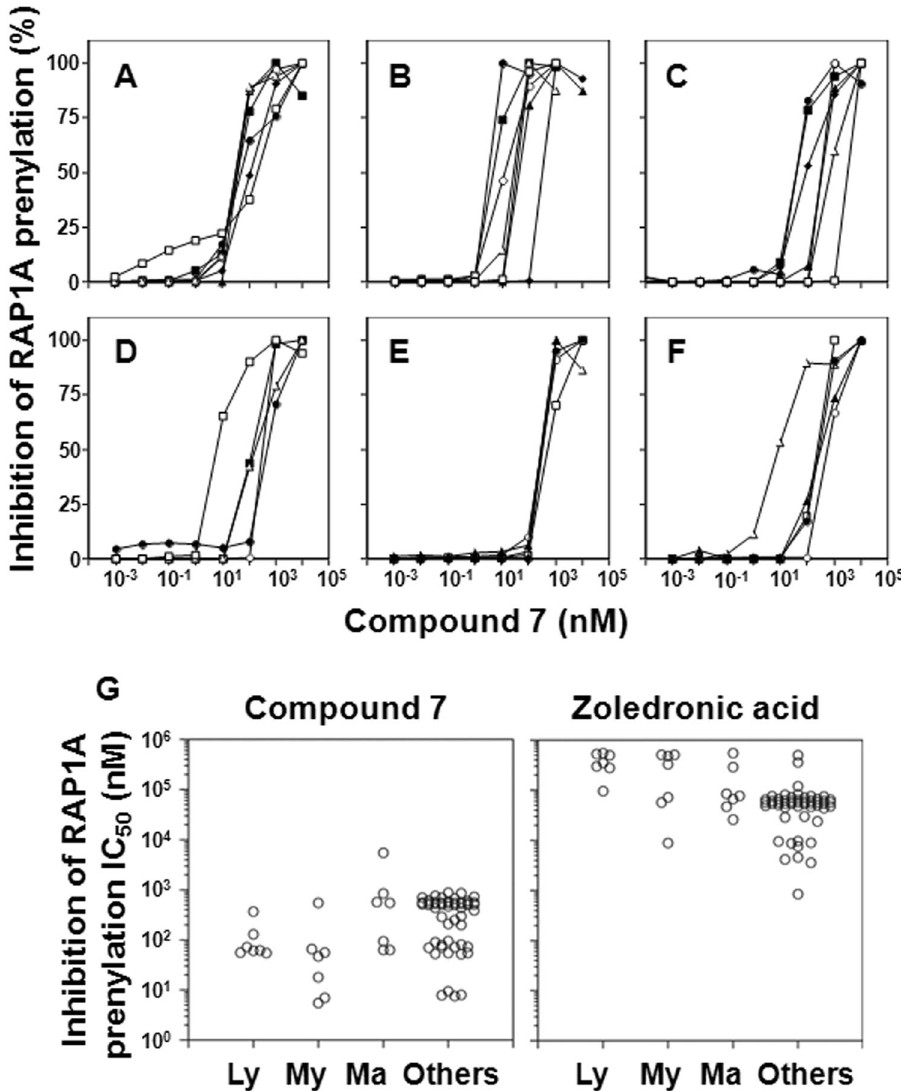
Figure 4. Inhibition of geranylgeranylation of RAP1A in tumor cells by compound 7 . Tumor cells were cultured with 7 for 16 h, lysed, and the prenylation of RAP1A assessed after protein separation by SDS-PAGE, transfer to PVDF membranes, and probing with anti-unprenylated RAP-1A antibodies. (A – F ) Compound 7 inhibition of geranylgeranylation of RAP1A for various types of tumor cell lines: ( A ) lymphomas, ▫ MOLT-3, ∆ PEER, ⚪ C1R, ⬧ J.RT3-T3.5, ▪ Raji, ▴ RAMOS-RA1, ⚫ MOLT-4; ( B ) myeloid leukemias, ▫ HL60, ∆ U937, ⚪ THP-1, ⬧ SCC-3, ▪ P31/FUJ, ▴ K562, ⚫ NOMO-1; ( C ) mammary carcinomas, ▫ YMB-1-E, ∆ MRK-nu-1, ⚪ HMC-1-8, ⬧ MCF-7, ▪ MDA-MB-231, ▴ T-47D, ⚫ SK-BR-3; ( D ) renal cell carcinomas, ▴ 786-0, ∆ VMRC- RCZ, ⚫ UOK121, ⚪ Caki-1, ▪ A-704; ( E ) pancreatic carcinomas, ⚫ BXPC-3, ▴ KP4-1, ⚪ KP4-2, ▫ KP4-3, ∆ MiaPaCa2; ( F ) other tumor cells, ⚫ TGB24TKB cholangiocell carcinoma, ▴ ACS gastric carcinoma, ⚪ MG63 osteocarcoma, ▫ LK-2 lung carcinoma, ∆ EJ-1 bladder carcinoma. ( G ) Comparison of compound 7 (left panel) with zoledronic acid (right panel) concentrations required for half-maximal inhibition of prenylation of RAP1A in tumor cells. Ly = lymphomas, My = myeloid leukemia, Ma = mammary carcinomas, and Others = other tumor cell lines. Data for zoledronic acid effects are from Idrees et al . 46 and are included for